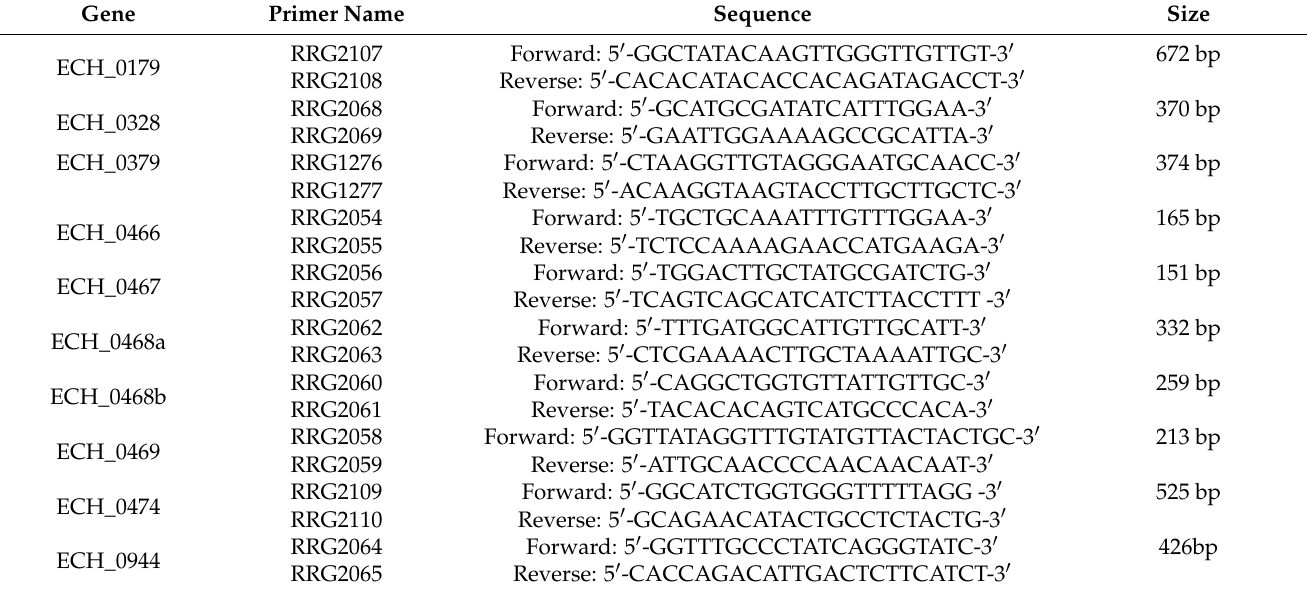
Table 2. Primers used for the semi